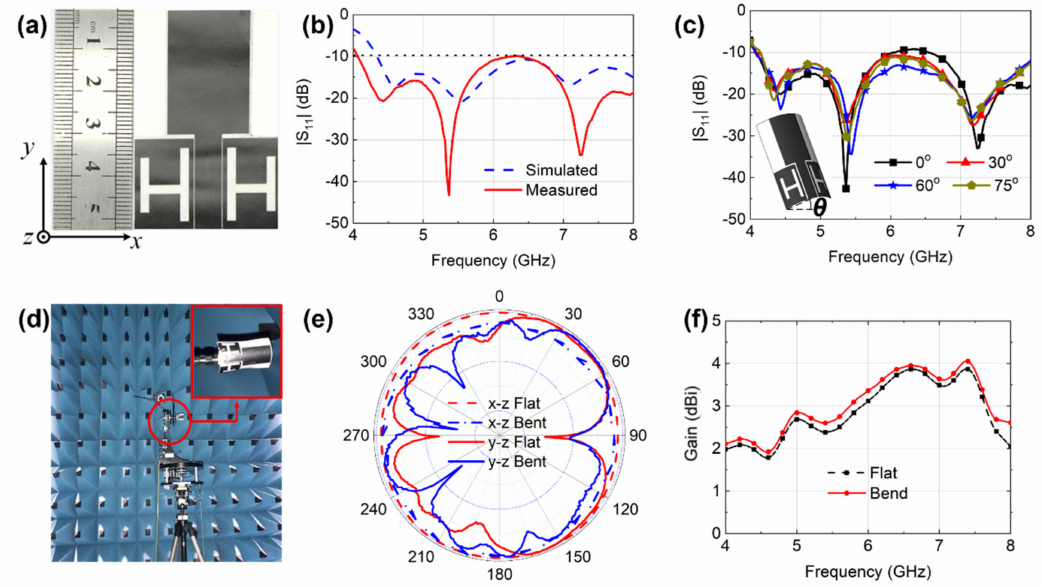
Figure 3. ( a ) The fabricated GAF antenna prototype. ( b ) Simulated (dashed blue line) and measured (red line) | S 11 | curves of the GAF antenna. ( c ) The measured | S 11 | curves of the GAF antenna with various bending angles of 0 ◦ , 30 ◦ , 60 ◦ , and 75 ◦ . ( d ) The anechoic chamber for radiation pattern measurement. ( e ) The measured radiation patterns of the antenna at 5.6 GHz in its flat (red) and bent (blue) state. ( f ) Measured gain of the antenna in its flat (black) and bent (red)